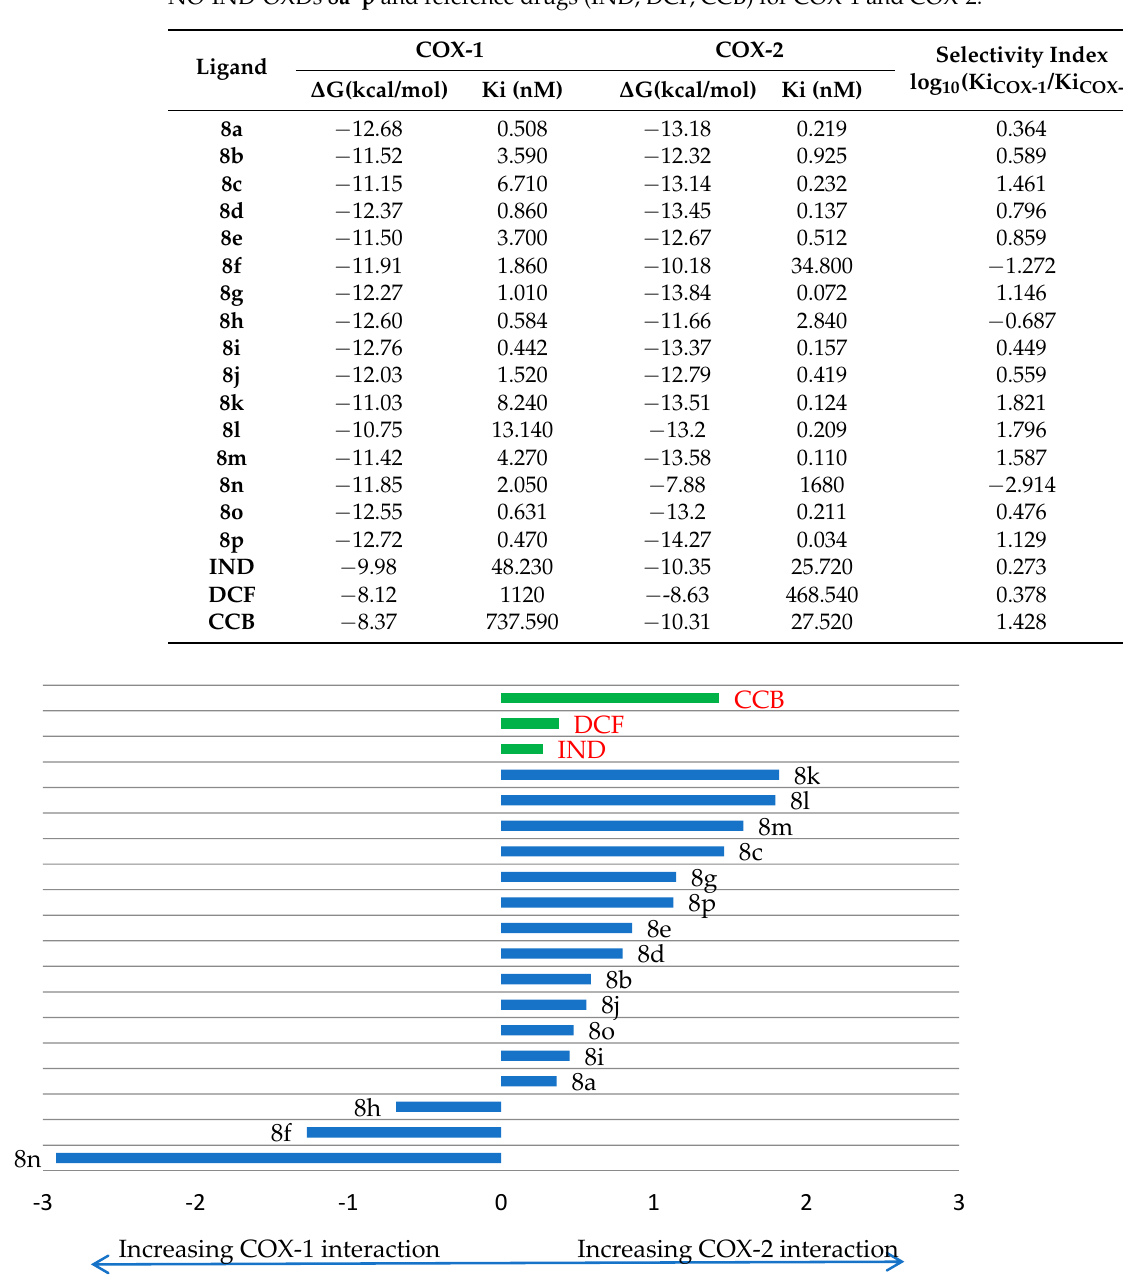
Table 1. Docking score ( Δ G, kcal/mol) and inhibition effect rate (Ki) during docking simulation of NO-IND-OXDs 8a-p and reference drugs (IND, DCF, CCB) for COX-1 and COX-2. COX-1 COX-2 Ligand